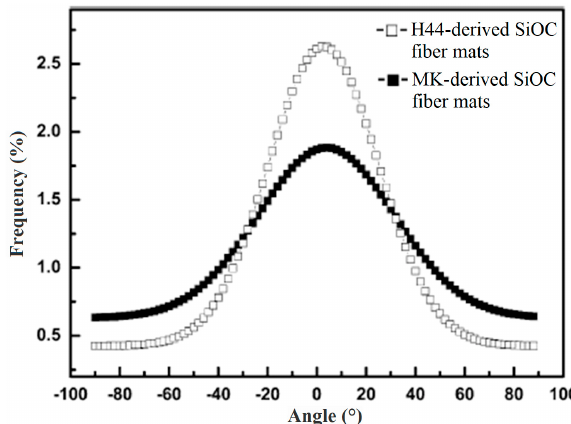
Figure 13. A typical directionality (angle distribution) of SiOC Nfs prepared with different precursors. Reprinted with permission from Ref. [57]. Copyright © Springer Science+Business Media New York 2015.